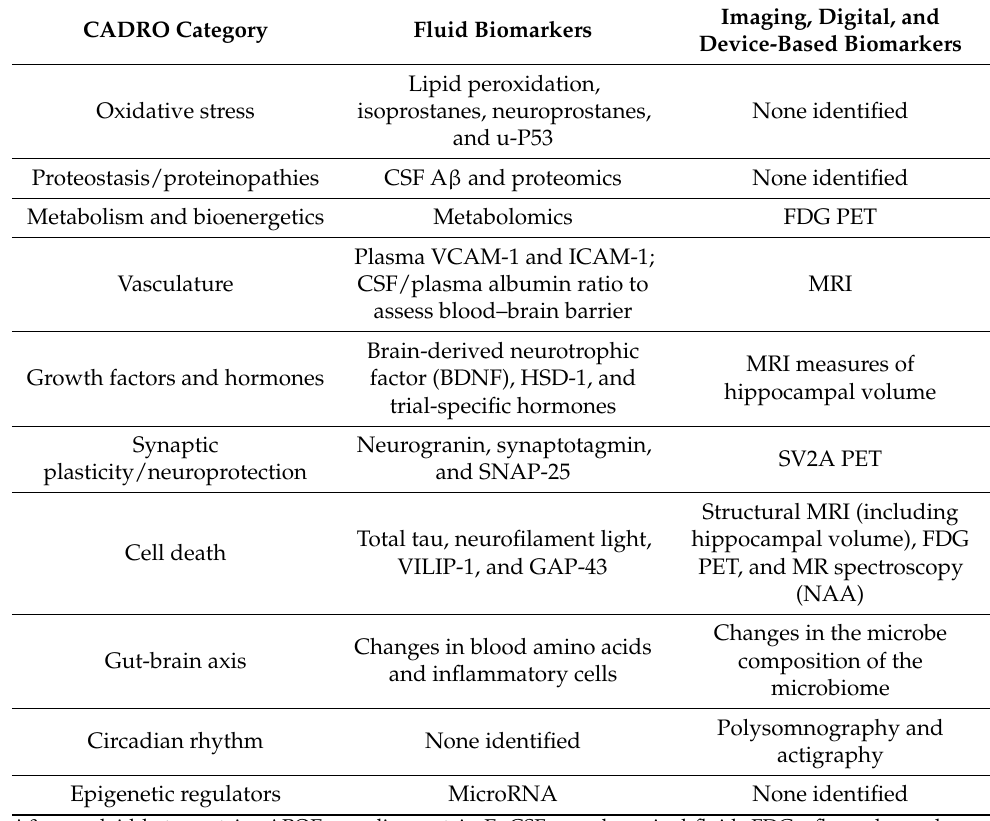
Imaging, Digital, and